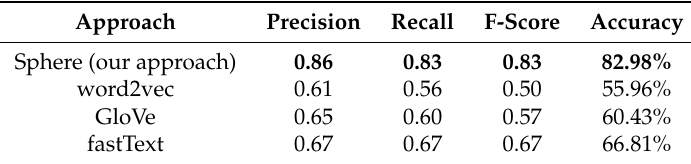
Table 5. Antonym/synonym discrimination results—adjectives.